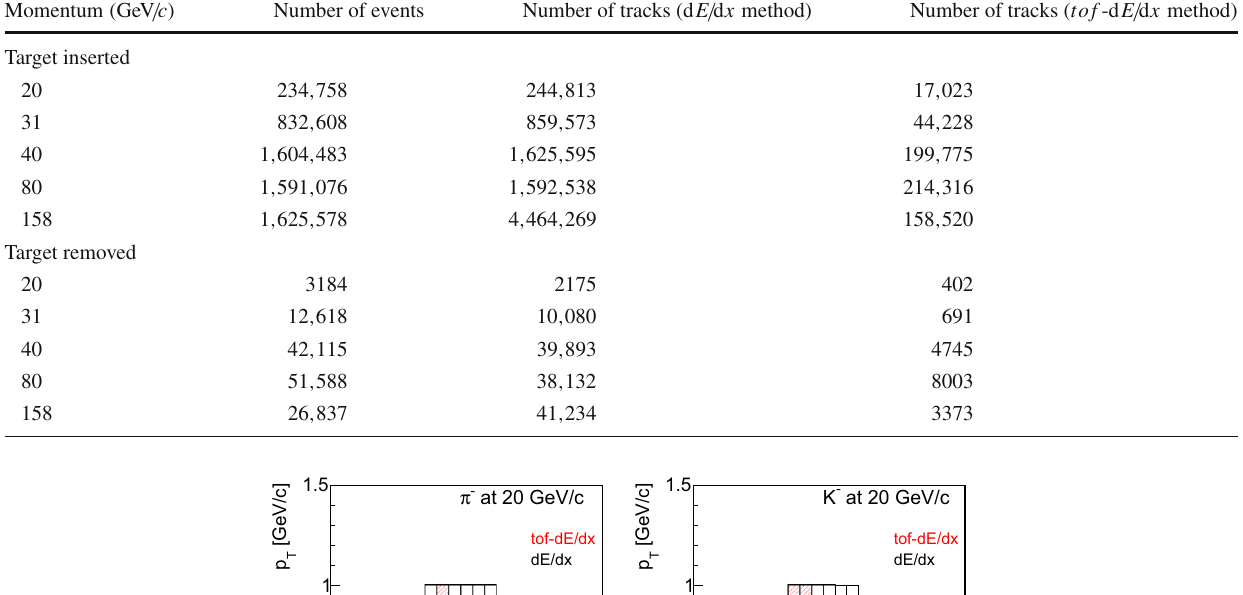
Table 2 Statistics of events and tracks used in d E / d x and tof -d E / d x identification methods for target inserted and removed configurations. Events with removed target were used to evaluate corrections for off-target interactions Momentum ( GeV / c ) Number of events Number of tracks (d E / d x method) Number of tracks ( tof -d E / d x method)